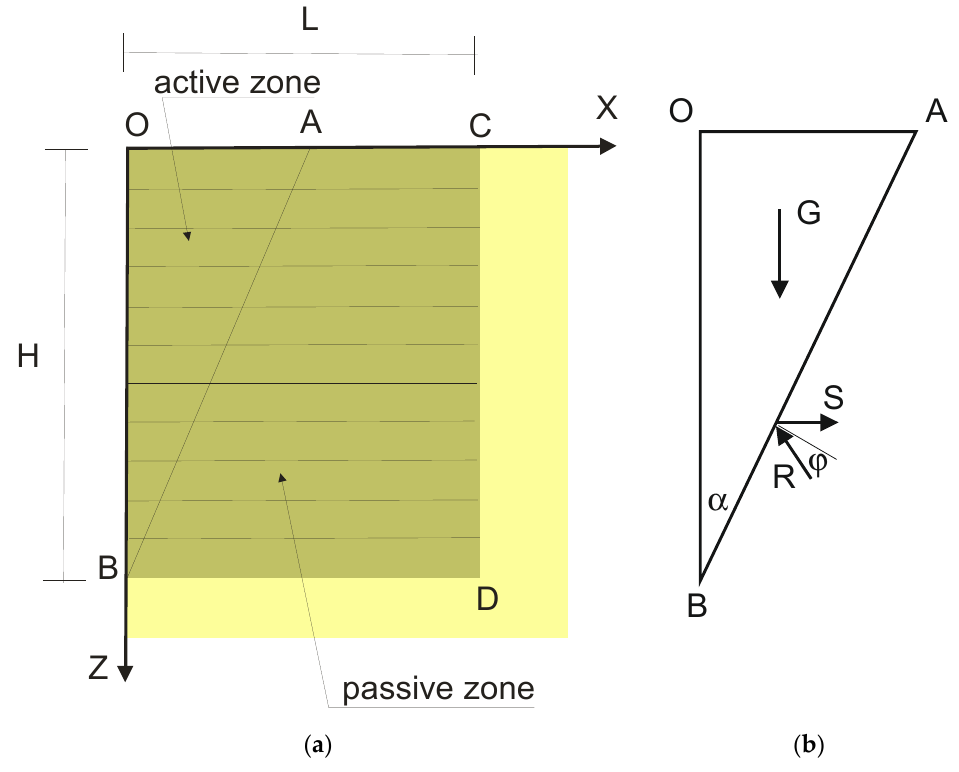
Figure 11. General model of the RS wall ( a ) and equilibrium of the failure wedge ( b ).